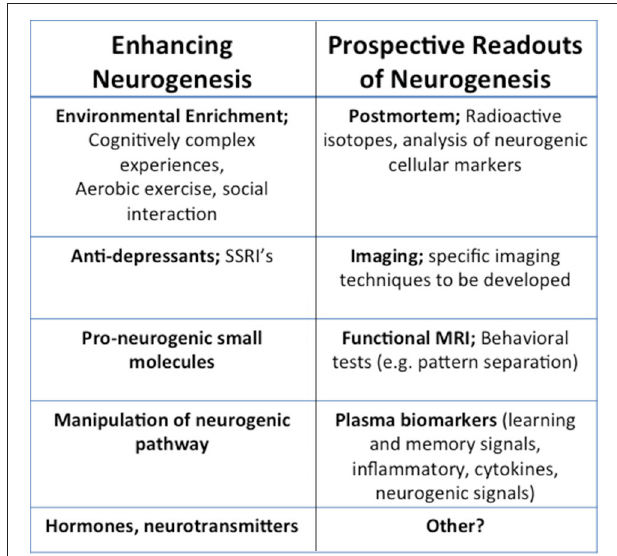
FIGURE 2 | Therapeutic and translational potential of neurogenesis. Examples of current and prospective methods for the modulation and detection of neurogenesis. Means of enhancing neurogenesis include noninvasive, environmental modulations like cognitively complex activities and exercise, as well as molecular interventions like anti-depressants, pro-neurogenic small molecules, hormones or neurotransmitters, or other manipulations of the neurogenic pathways. While readouts of human neurogenesis are typically done in postmortem tissue using radioactive isotopes or analysis of neurogeneic cell markers, imaging techniques such as fMRI, or blood biomarkers will offer non-invasive avenues to determine neurogenesis during